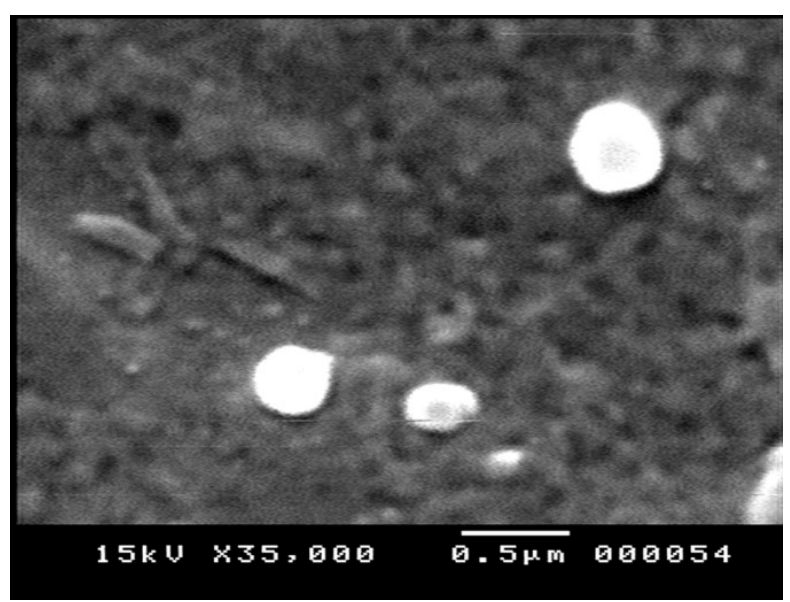
Figure 1. Scanning electron micrograph of the GSH-NLCs.